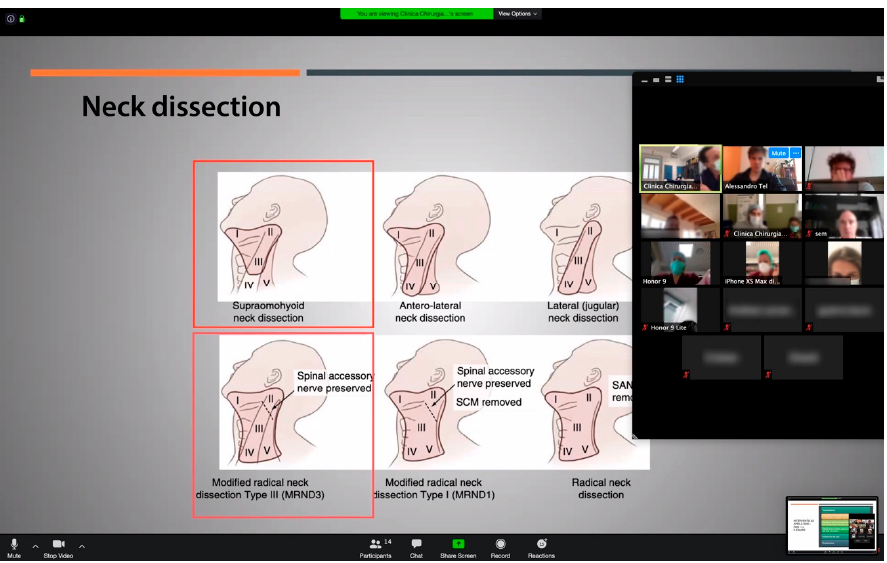
Figure 1. Multidisciplinary meeting with multiple participants, including anesthesiology team. A case of oncological surgery is discussed using Zoom. Int. J. Environ. Res. Public Health 2020 , 17 , x